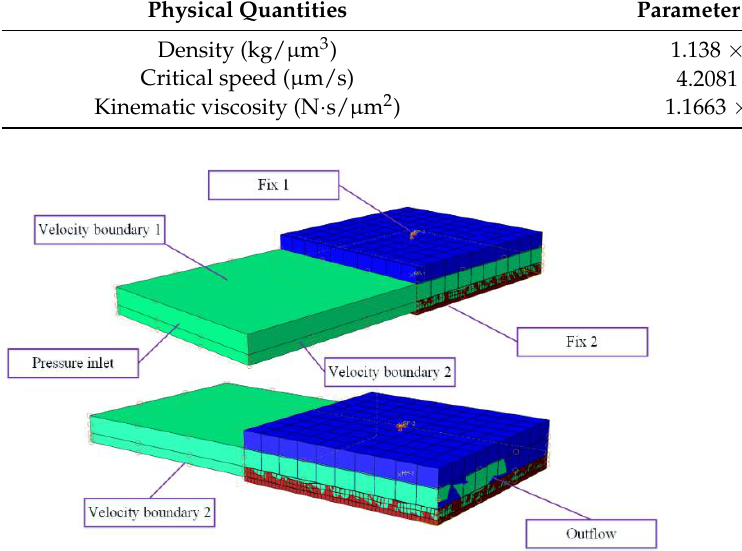
Table 2. Physical parameters of nitrogen.